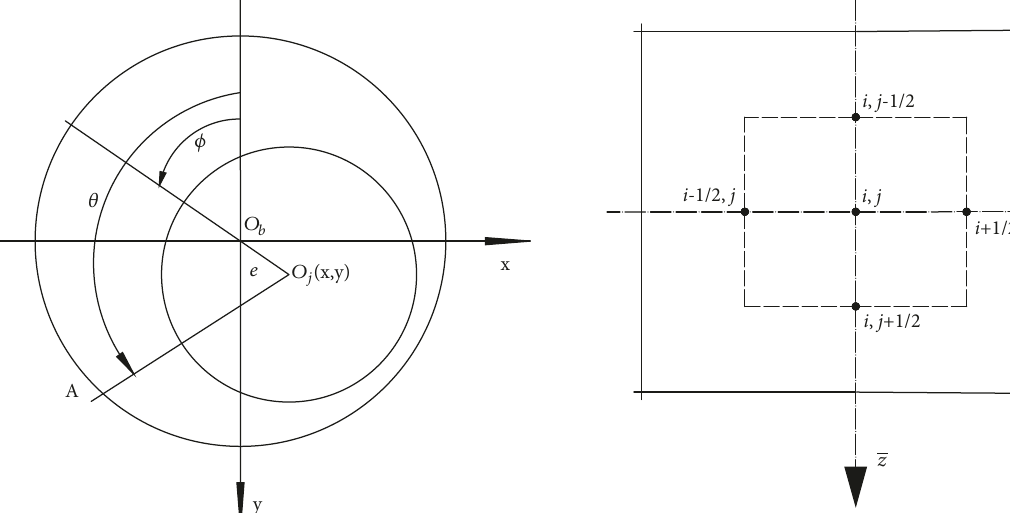
Figure 5: Grid division of sliding